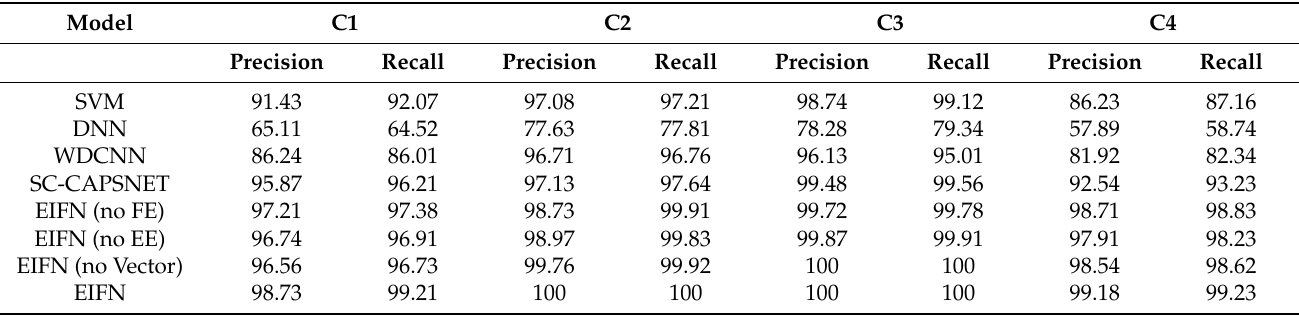
Table 4. Fault diagnosis precision (%) and recall (%) of models.